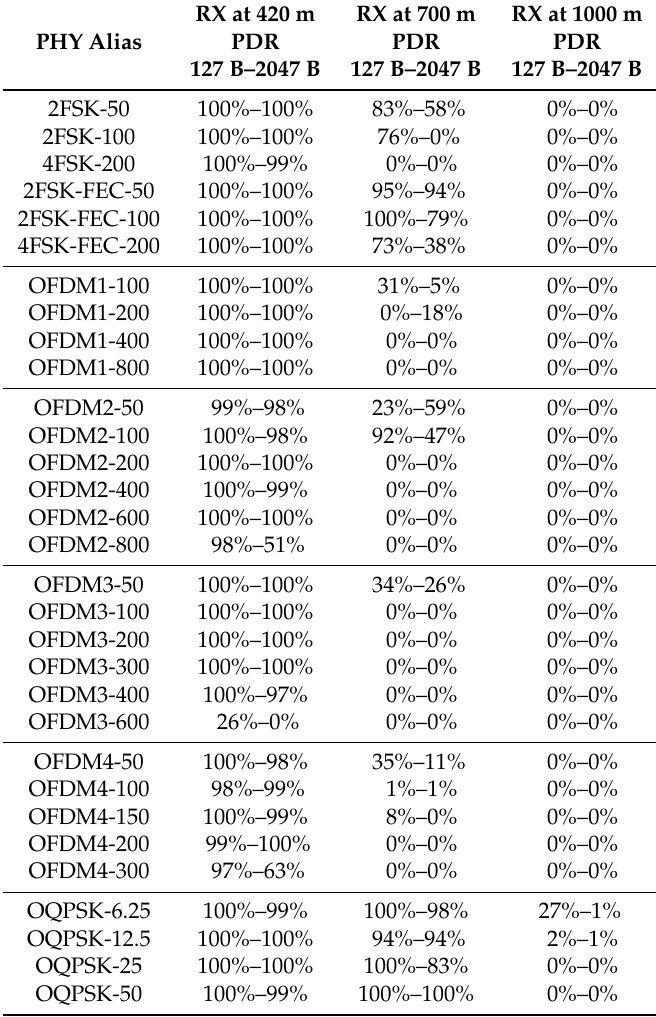
Table 7. Line of Sight. PDR considering packets of 127 B and 2047 B for each RX node. High data rates with high PDR are achieved at least up to 420 m from the TX node. Maximum length of the radio link is close to 700